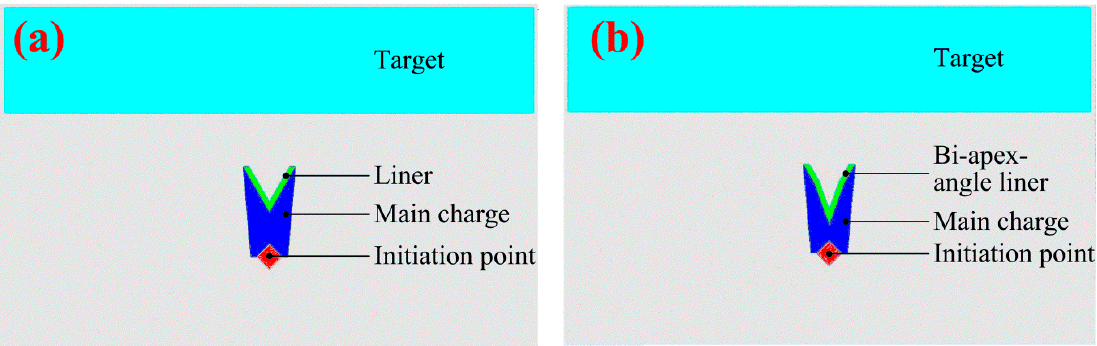
Figure 6. Numerical model of shaped charges: ( a ) LSC; ( b ) BLSC.